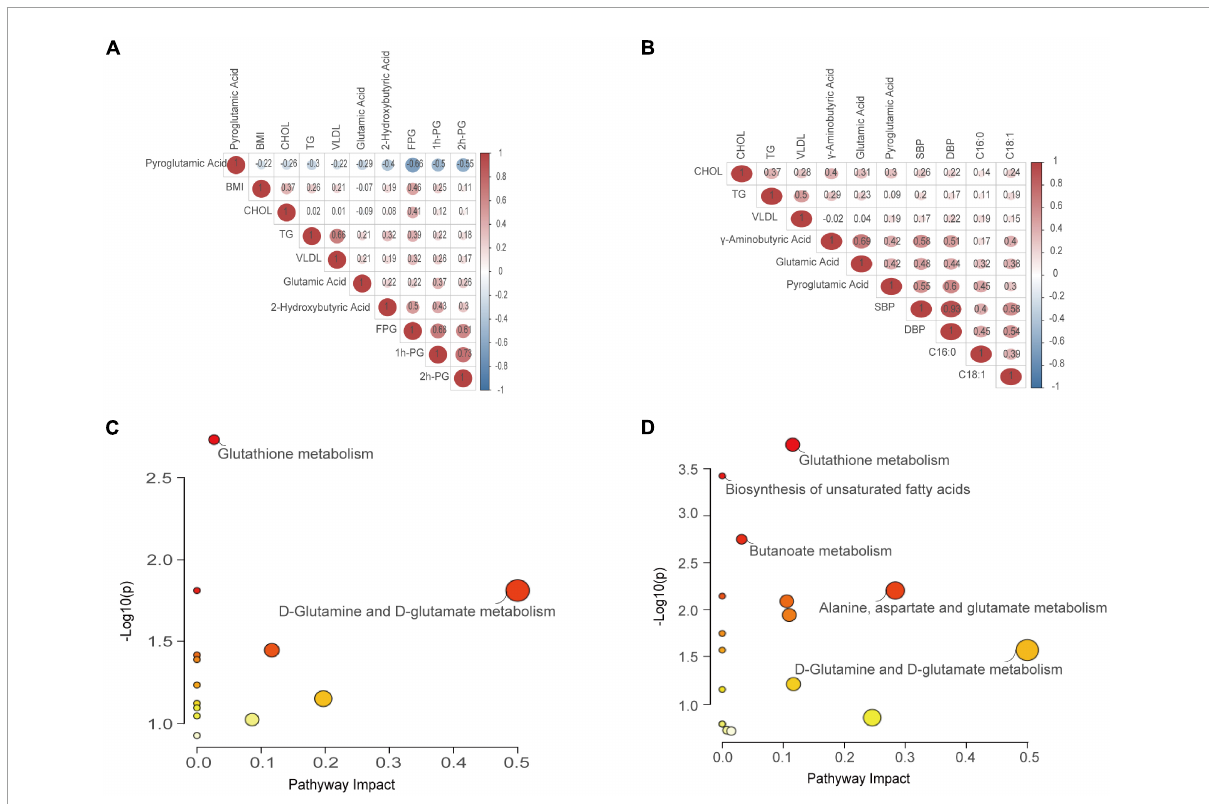
FIGURE5 Correlation analysis and pathway enrichment analysis. (A) Correlation analysis between the screened differential metabolites and phenotypes referring to GDM. (B) Correlation analysis between the screened differential metabolites and phenotypes referring to HP. Values in red denote a positive trend, whereas those in green denote a negative trend. (C) Metabolic pathway reprogramming refers to GDM. (D) Metabolic pathway reprogramming refers to HP. Colors varying from yellow to red denote metabolites with differing levels of significance. Node shapes varying from small to large denote the number of metabolites included in a